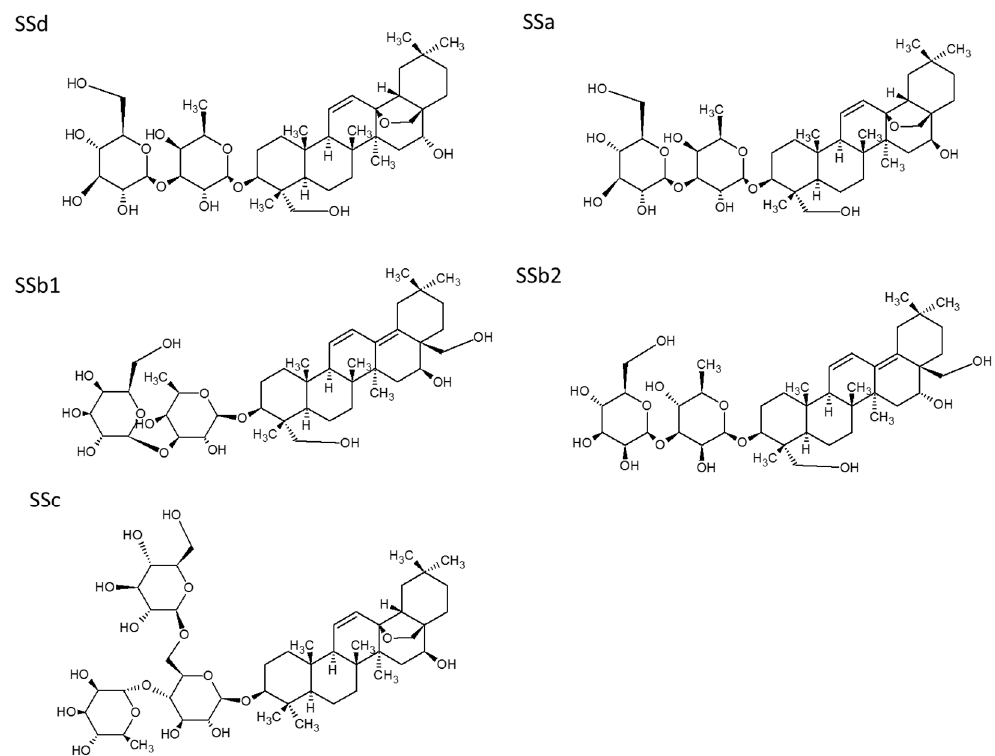
Figure 3. Chemical structures of saikosaponin a, saikosaponin b1, saikosaponin b2 saikosaponin c and saikosaponin d.